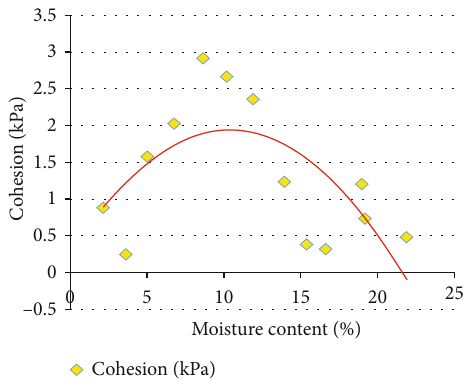
Figure 4: Change trends of the cohesion with di ff erent water content levels in the coal samples.